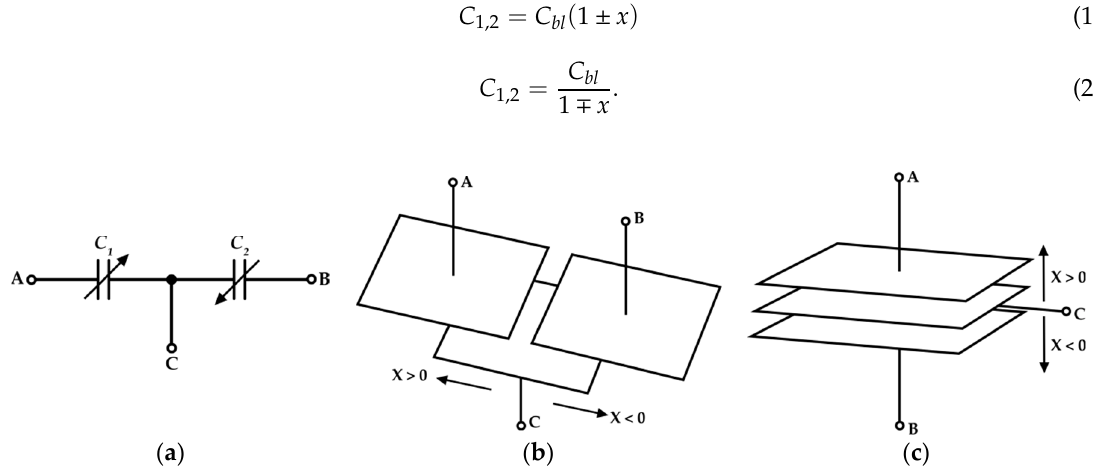
Figure 1. Differential capacitive sensor ( a ) schematic and structure when the measurand influences ( b ) the overlapping area of plates; ( c ) the distance between plates.